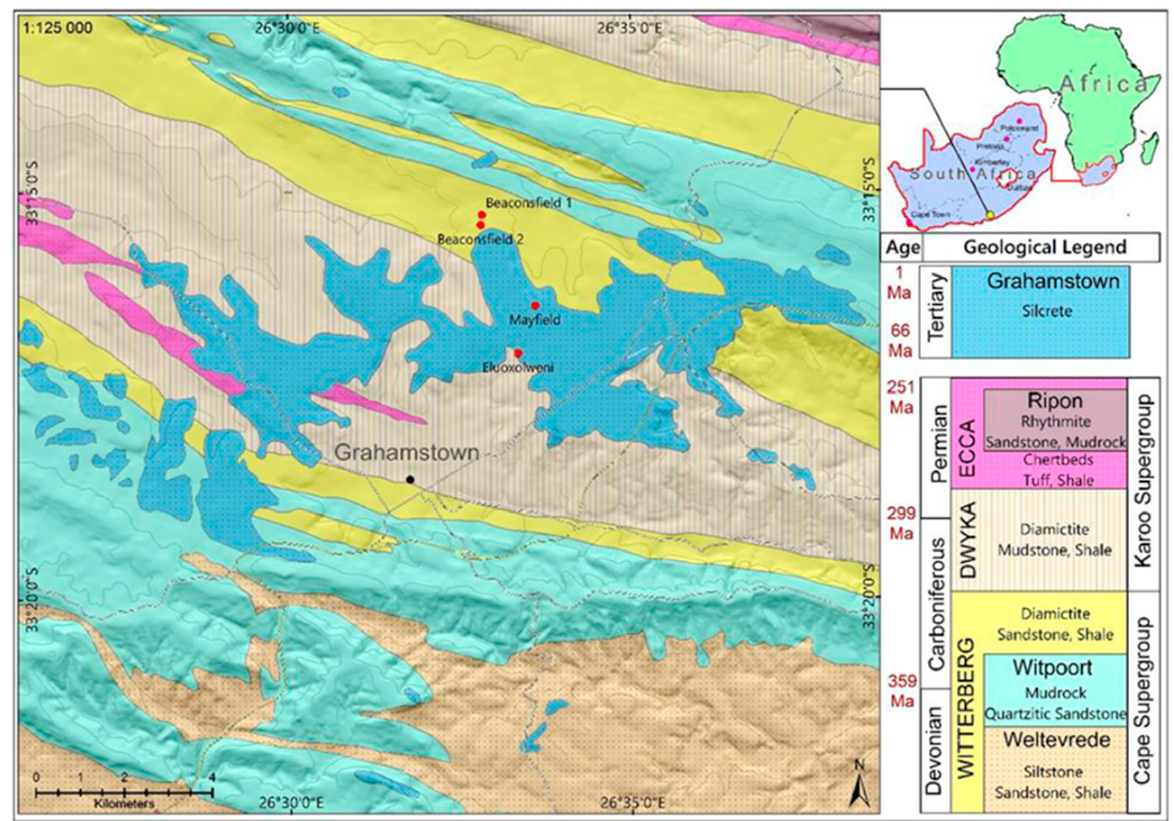
Figure 2. Geological map of Grahamstown.